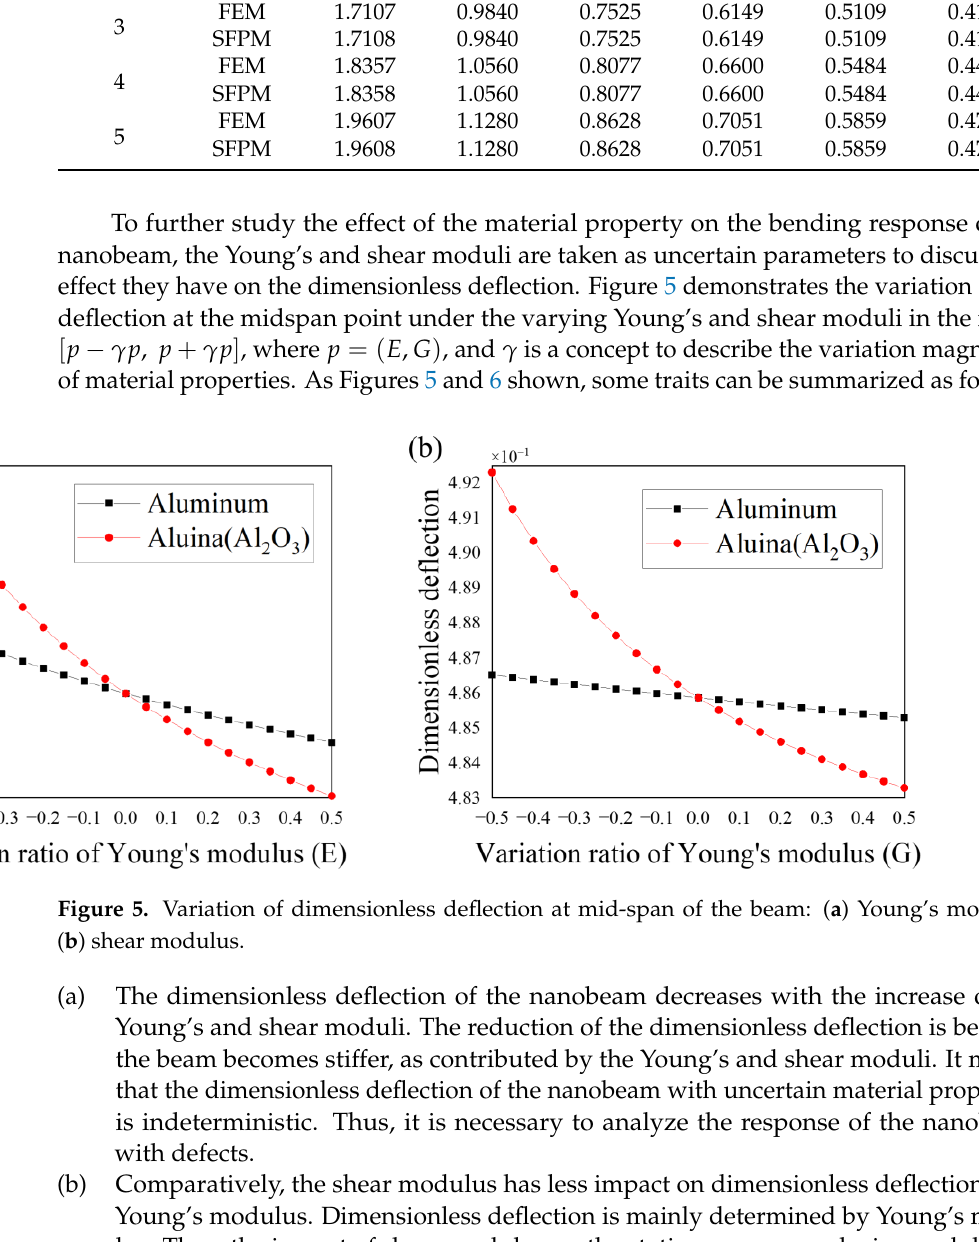
Figure 6. Dimensionless deflection along the axial direction: ( a ) Young’s modulus of aluminum; ( b ) Young’s modulus of alumina; ( c ) shear modulus of aluminum; ( d ) shear modulus of alumina. (a) The dimensionless deflection of the nanobeam decreases with the increase of the Young’s and shear moduli. The reduction of the dimensionless deflection is because the beam becomes stiffer, as contributed by the Young’s and shear moduli. It means that the dimensionless deflection of the nanobeam with uncertain material properties